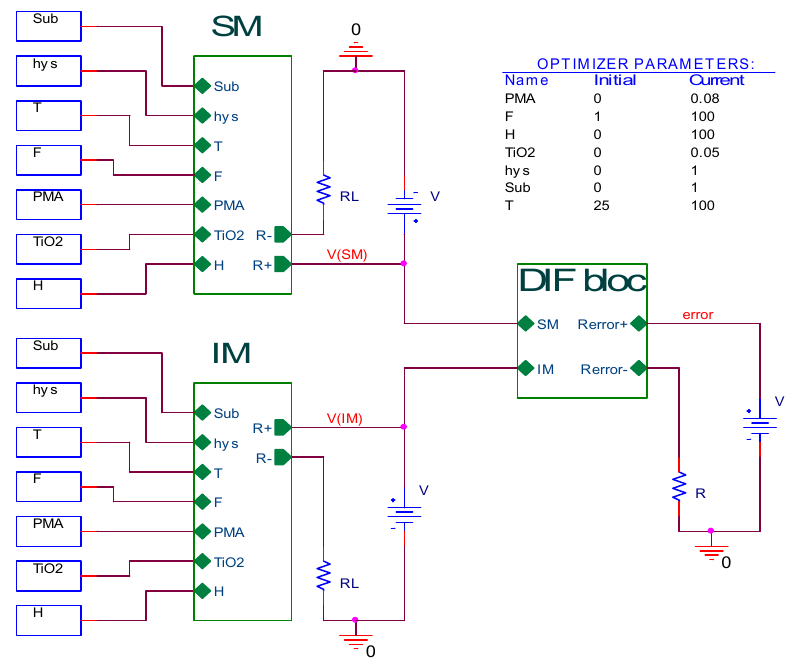
Figure 7. Electrical circuit.